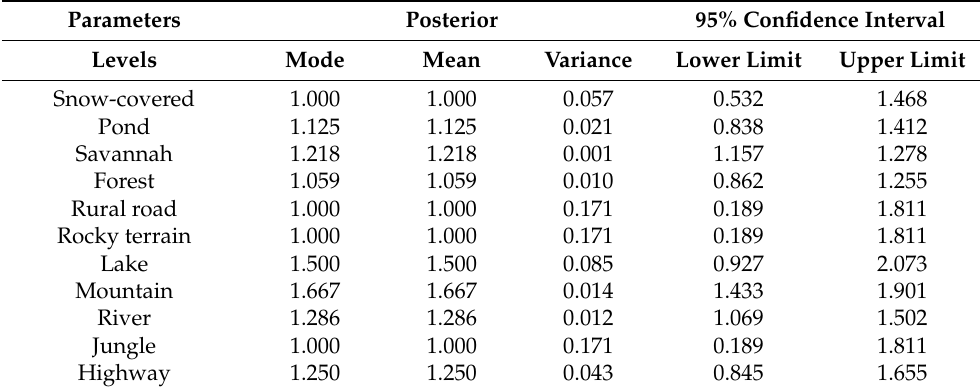
Table 8. Summary of descriptive statistics of the posterior distribution for the relief